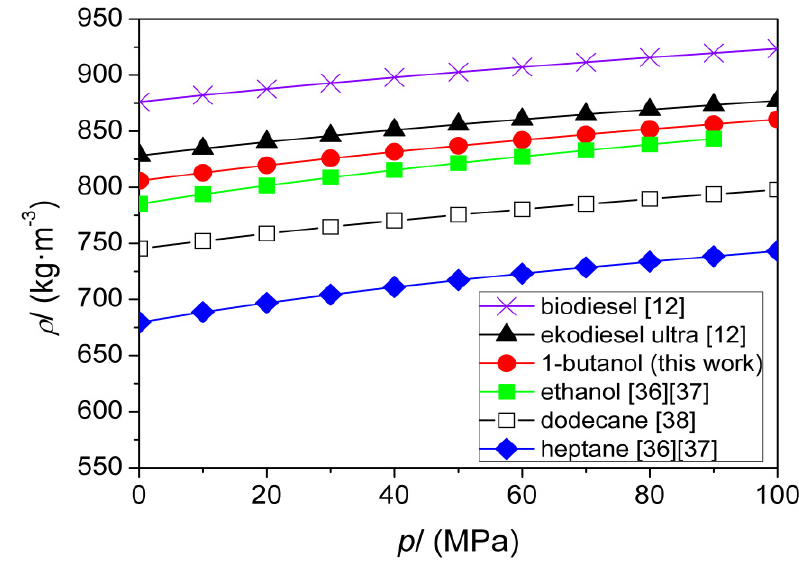
Figure 13. The pressure dependence of density of heptane and dodecane—fuel components, ethanol—the most common used bioalcohol, low sulfur diesel oil (ekodiesel ultra) and biodiesel (FAME) at 298.15 K.